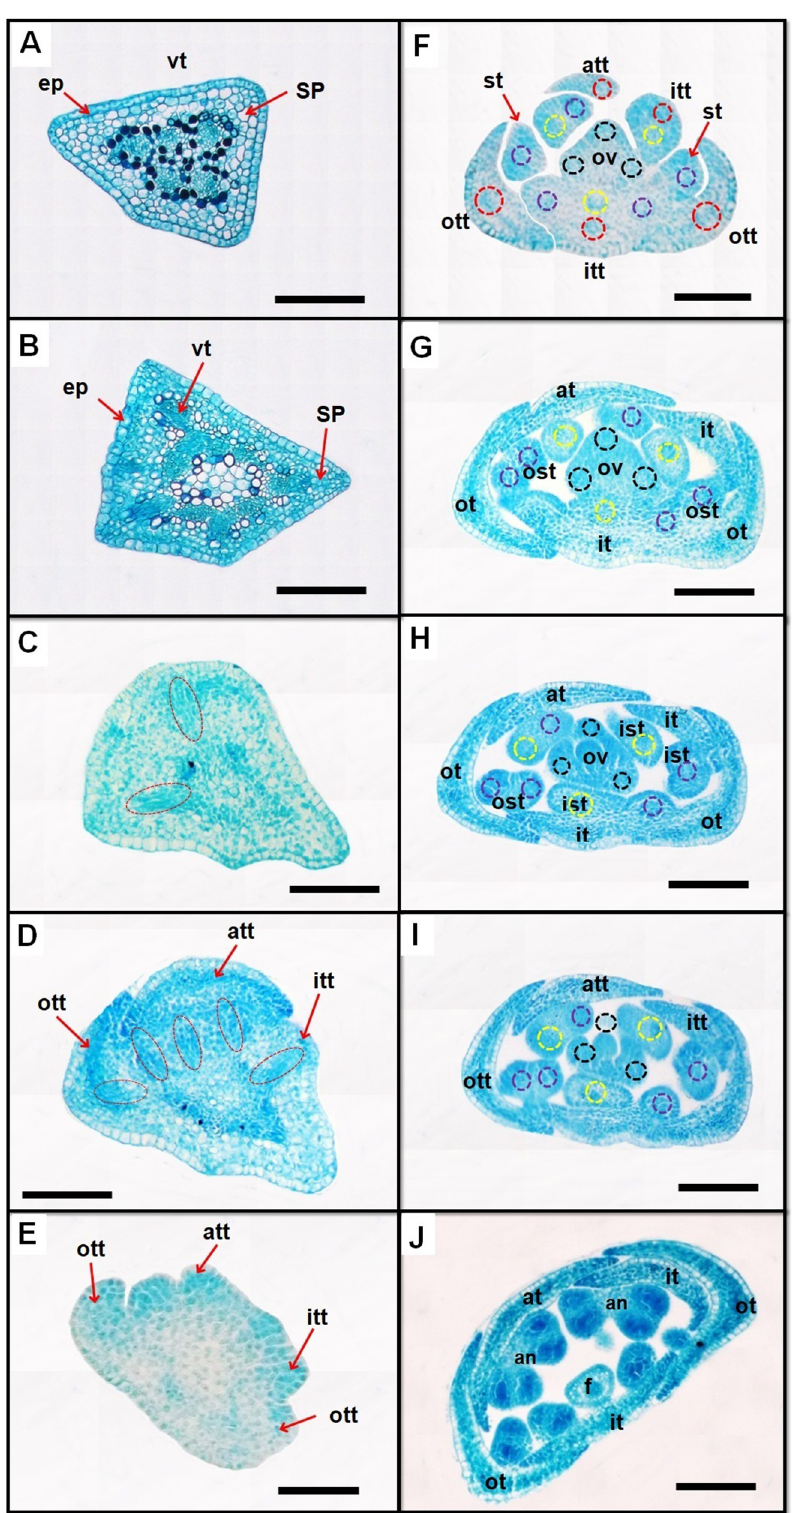
Fig 5. Floral vasculature. P . equisetiforme in transverse sections of developing flowers (A, B, C, D, E, F, G, H, I and J). Abbreviations: ep, epidermis; vt, vascular trace; SP, spangy parenchyma; att, alternate tepal trace; ott, outer tepal trace; itt, inner tepal trace; st, stamen trace; ost, outer stamen trace; ist, inner stamen trace; yellow circle, inner stamen trace; purple circle, outer stamen trace; red circle, tepal trace; black circle, ovary trace. Scale bars = 50 μ m. https://doi.org/10.1371/journal.pone.0227099.g005 PLOS ONE | https://doi.org/10.1371/journal.pone.0227099 January 10,